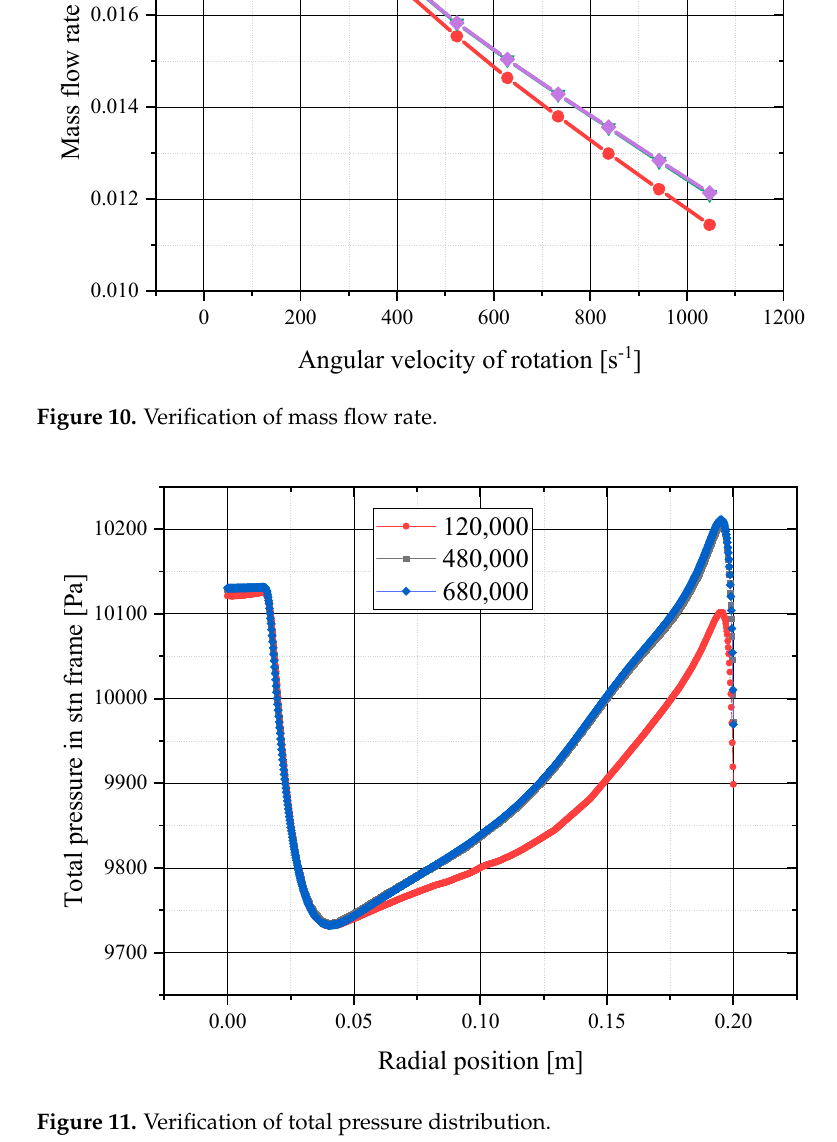
Figure 12. Verification of velocity distribution.